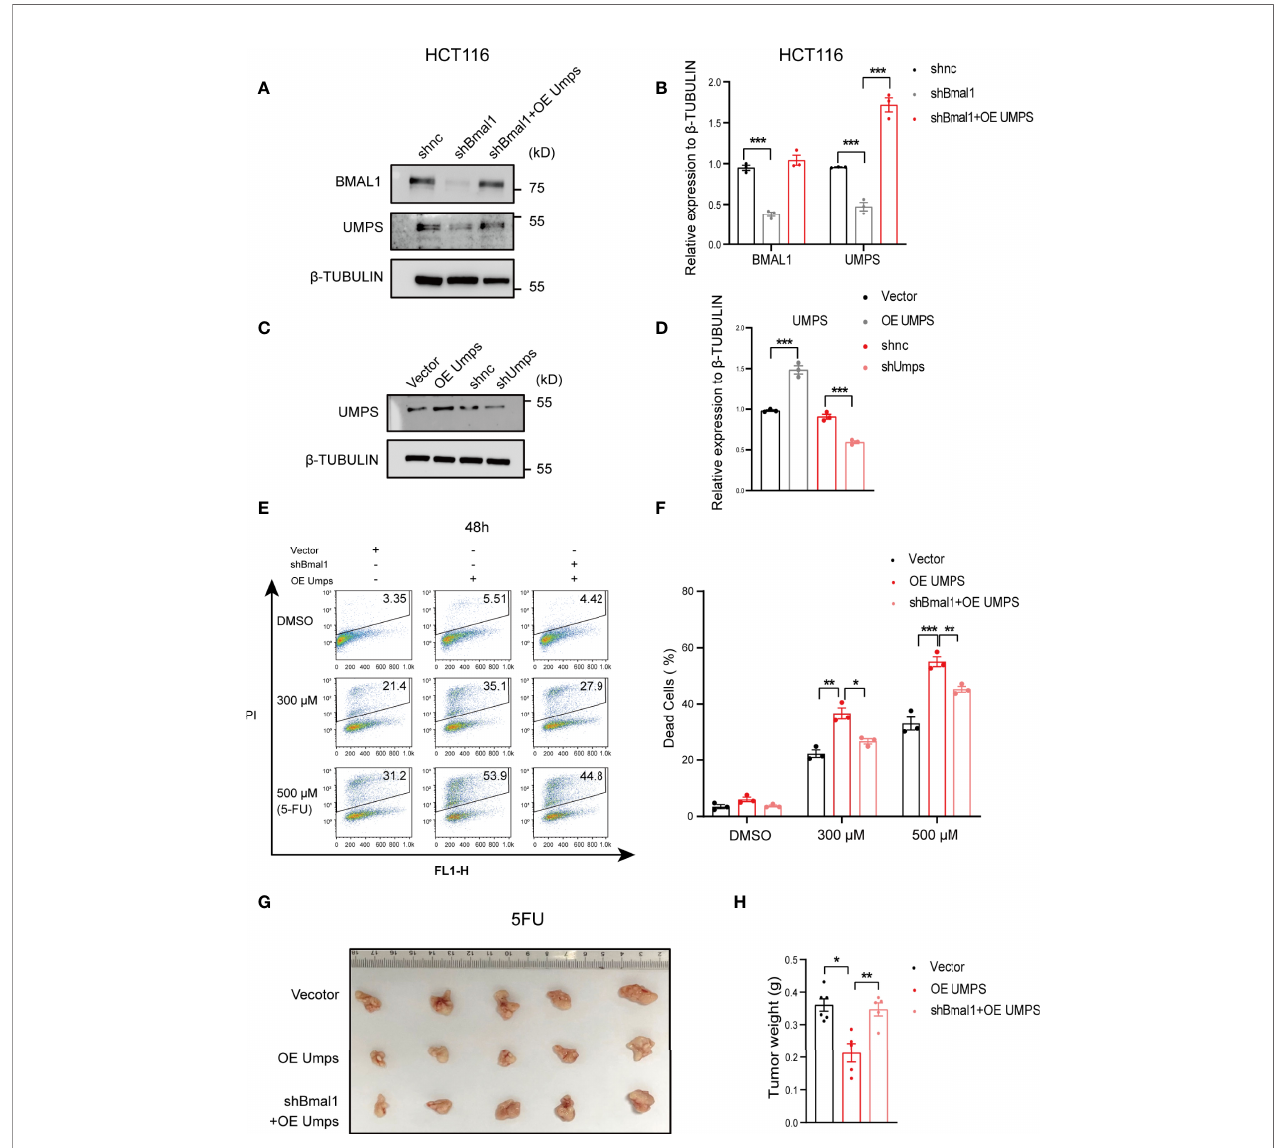
FIGURE 6 | UMPS enhances 5-FU sensitivity through BMAL1 in vitro and in vivo in CRC cells. (A, B) The protein expression levels of BMAL1 and UMPS upon simultaneous knockdown of BMAL1 with or without overexpression of UMPS in HCT116 cells via western blotting. (C, D) The protein expression levels of UMPS upon knockdown or overexpression in HCT116 cells via western blotting. (E, F) Dead cells were determined by fl ow cytometry of HCT116 cells with simultaneous knockdown of BMAL1 with or without overexpression of UMPS after treatment with 5-FU (0, 300 m M, 500 m M, 750 m M, 48 h). (n = 3, one-way ANOVA per concentration). (G, H) OE Umps or shBmal1+OEUmps stable HCT116 cells were subcutaneously injected into mice. One week after cell inoculation, mice were treated with 5-FU (30 mg kg − 1 , twice a week) at HALO16 for 4 weeks. (n = 5 or 6, unpaired t test). After 4 weeks of treatment, the tumors were resected and analyzed. * indicates p < 0.05, ** indicates p < 0.01, *** indicates p <